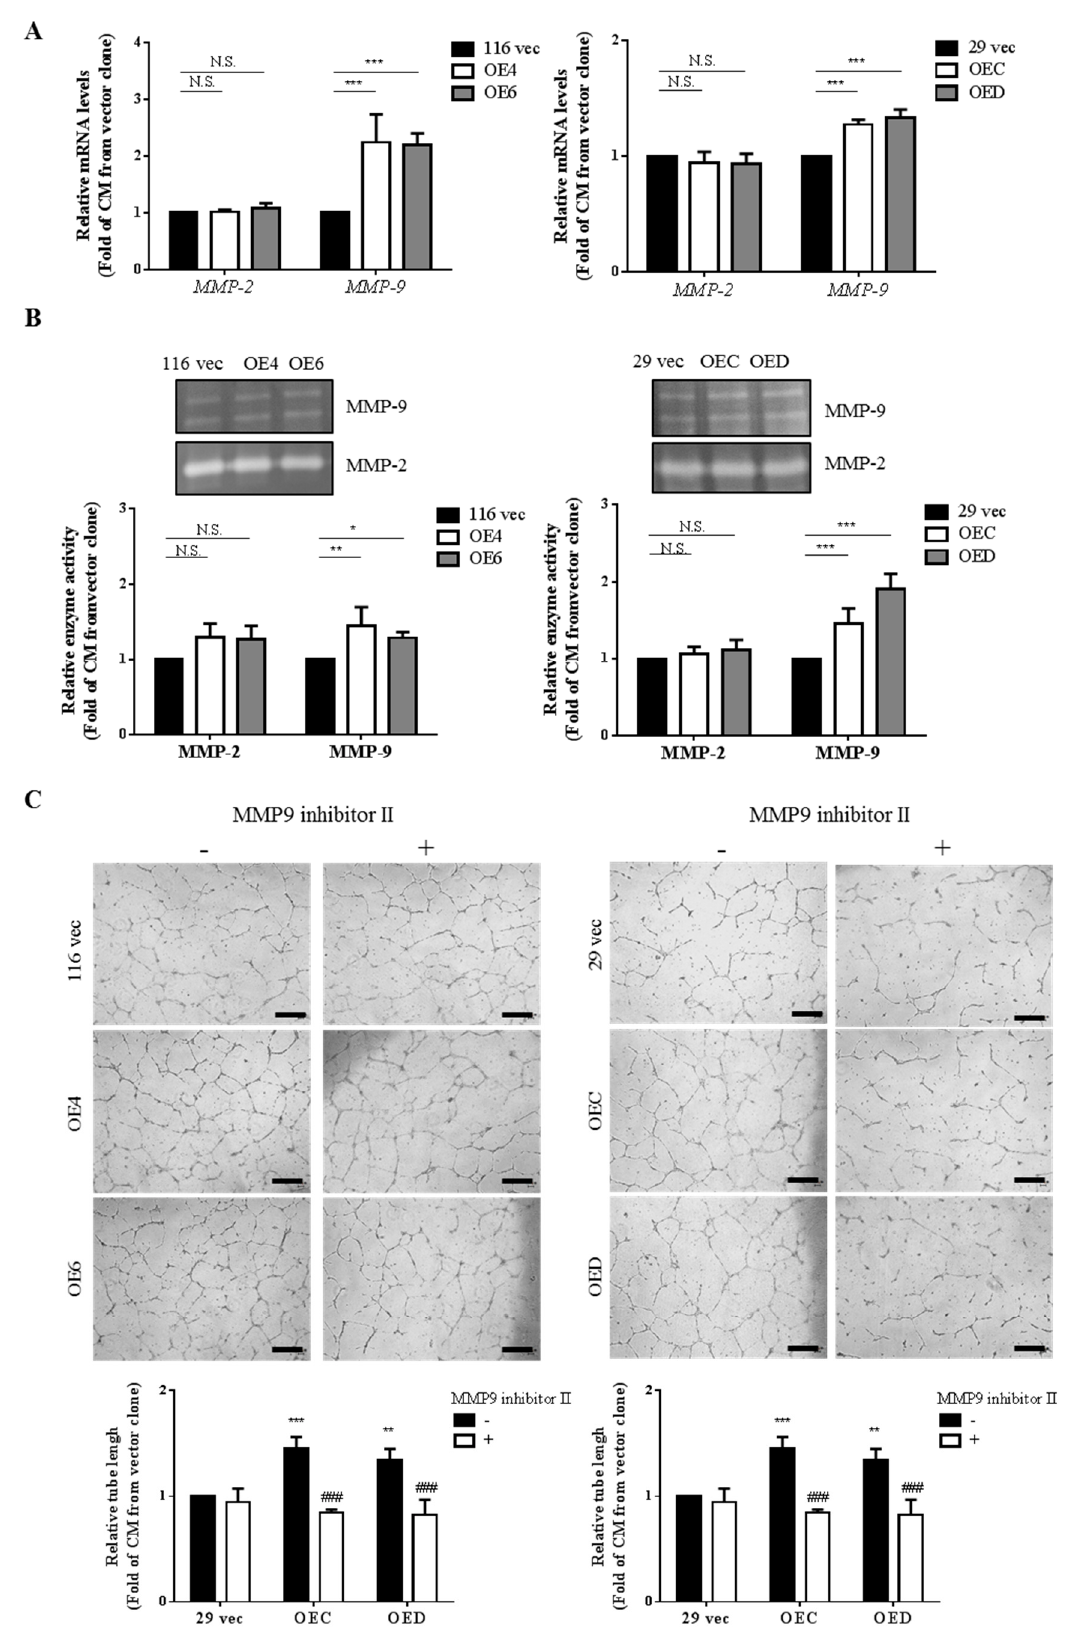
Figure 2. CM collected from the GATA6-overexpressing clones increase both the mRNA levels and activities of MMP-9 in HUVECs and the latter is critical for their tube formation. ( A ) Total RNAs (5 µ g) isolated from HUVECs after being